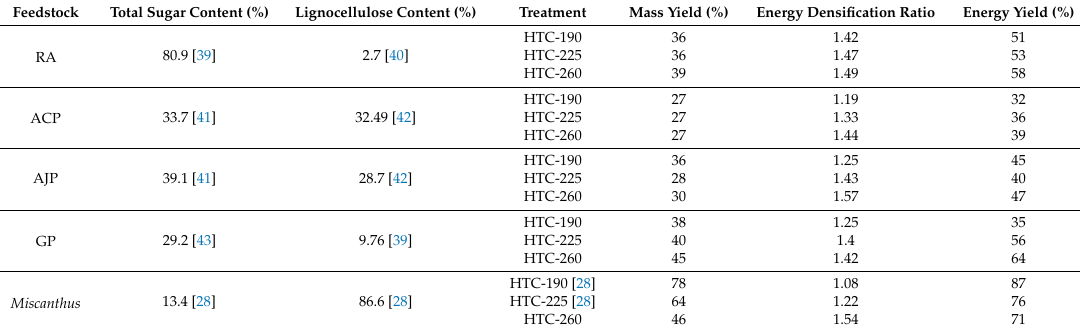
Table 2. Mass yield, energy yield, and energy densification